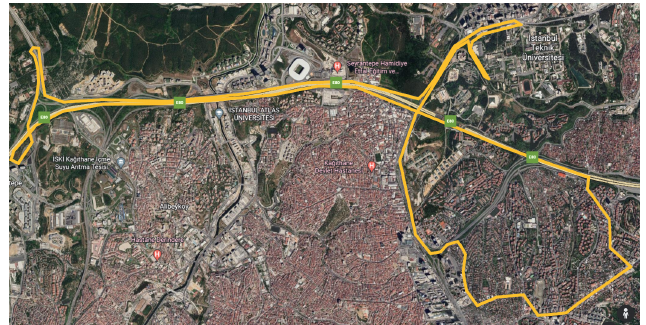
Figure 3. Uyanik route and its geographical location through different zones of Istanbul.